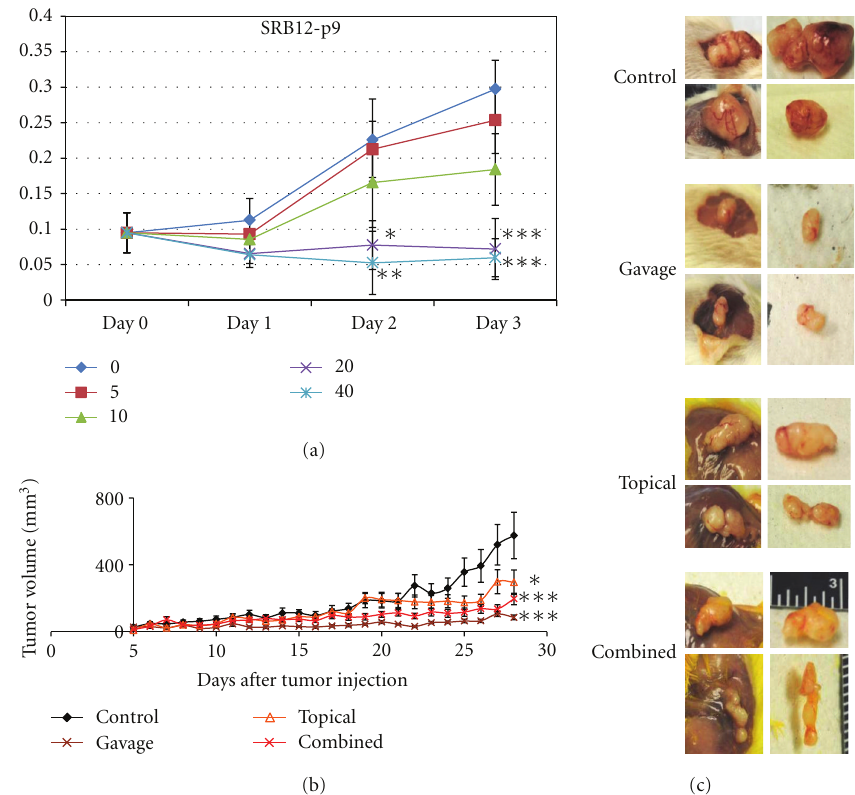
Figure 1: Curcumin inhibits skin SCC cell growth in vitro and in vivo . (a) Cell proliferation of the aggressive skin cancer cell line SRB12-p9 after treatment with 0–40 μ M curcumin. ∗ P < 0 . 05 versus control group; ∗∗ P < 0 . 01 versus control group; ∗∗∗ P < 0 . 001 versus control group. (b) Mice were pretreated with the indicated dose of curcumin for 3 days prior to injection with 1 × 10 6 SRB12-p9 tumor cells in the dorsal region (day 0) and continued receiving daily curcumin treatment (9 mice per group, mean tumor volume ± SD). Tukey’s post hoc test: ∗ P < 0 . 05 versus control group; ∗∗∗ P < 0 . 001 versus control group. (c) Representative images of xenograft tumors at harvest and ex vivo from the indicated treatment